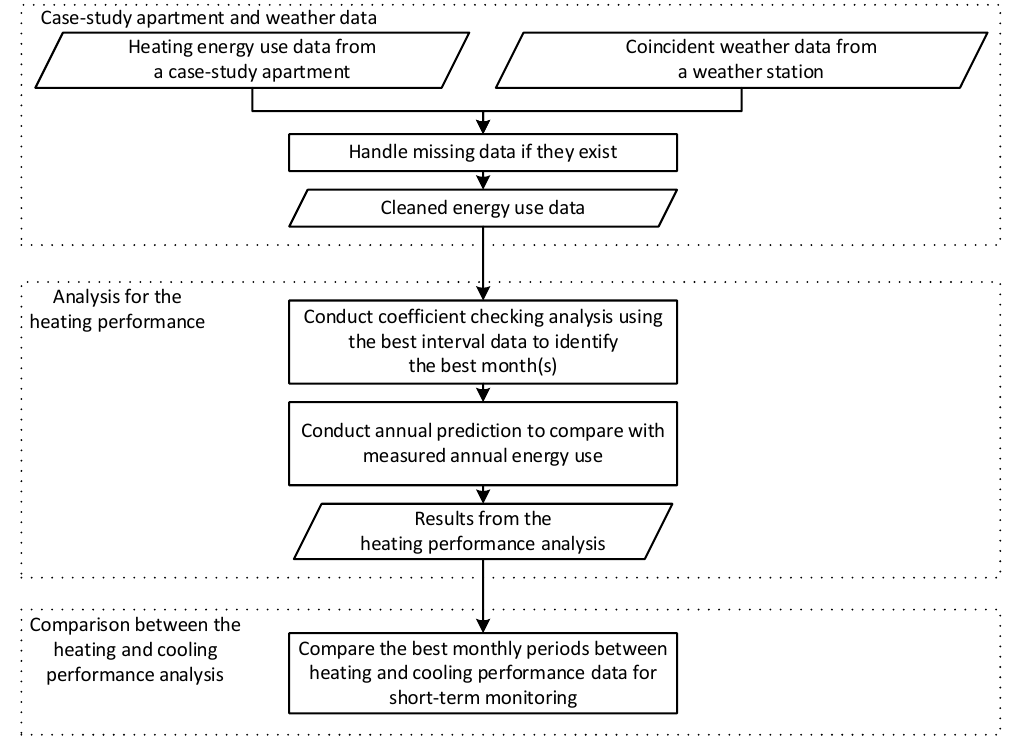
Figure 1. Overall procedures.